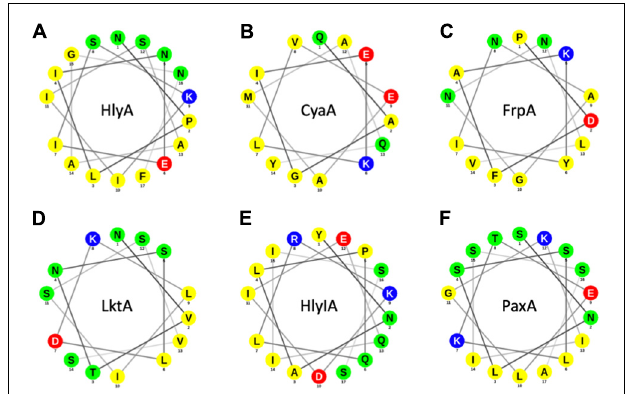
FIGURE 7 | Helical wheel projections of RTX proteins that can be secreted by the HlyBD-TolC apparatus. Helical wheels were drawn with NetWheel. Non-polar residues are shown in yellow, polar residues in green, basic residues in blue and acidic residues in red. Next to HlyA (A) , secretion by HlyBD-TolC has been shown for CyaA (B) by Masure et al. (1990), for FrpA (C) by Thompson and Sparling (1993), for LktA (D) by Highlander et al. (1990), for HlyIA (E) by Gygi et al. (1990) and for PaxA (F) by Kuhnert et al. (2000).